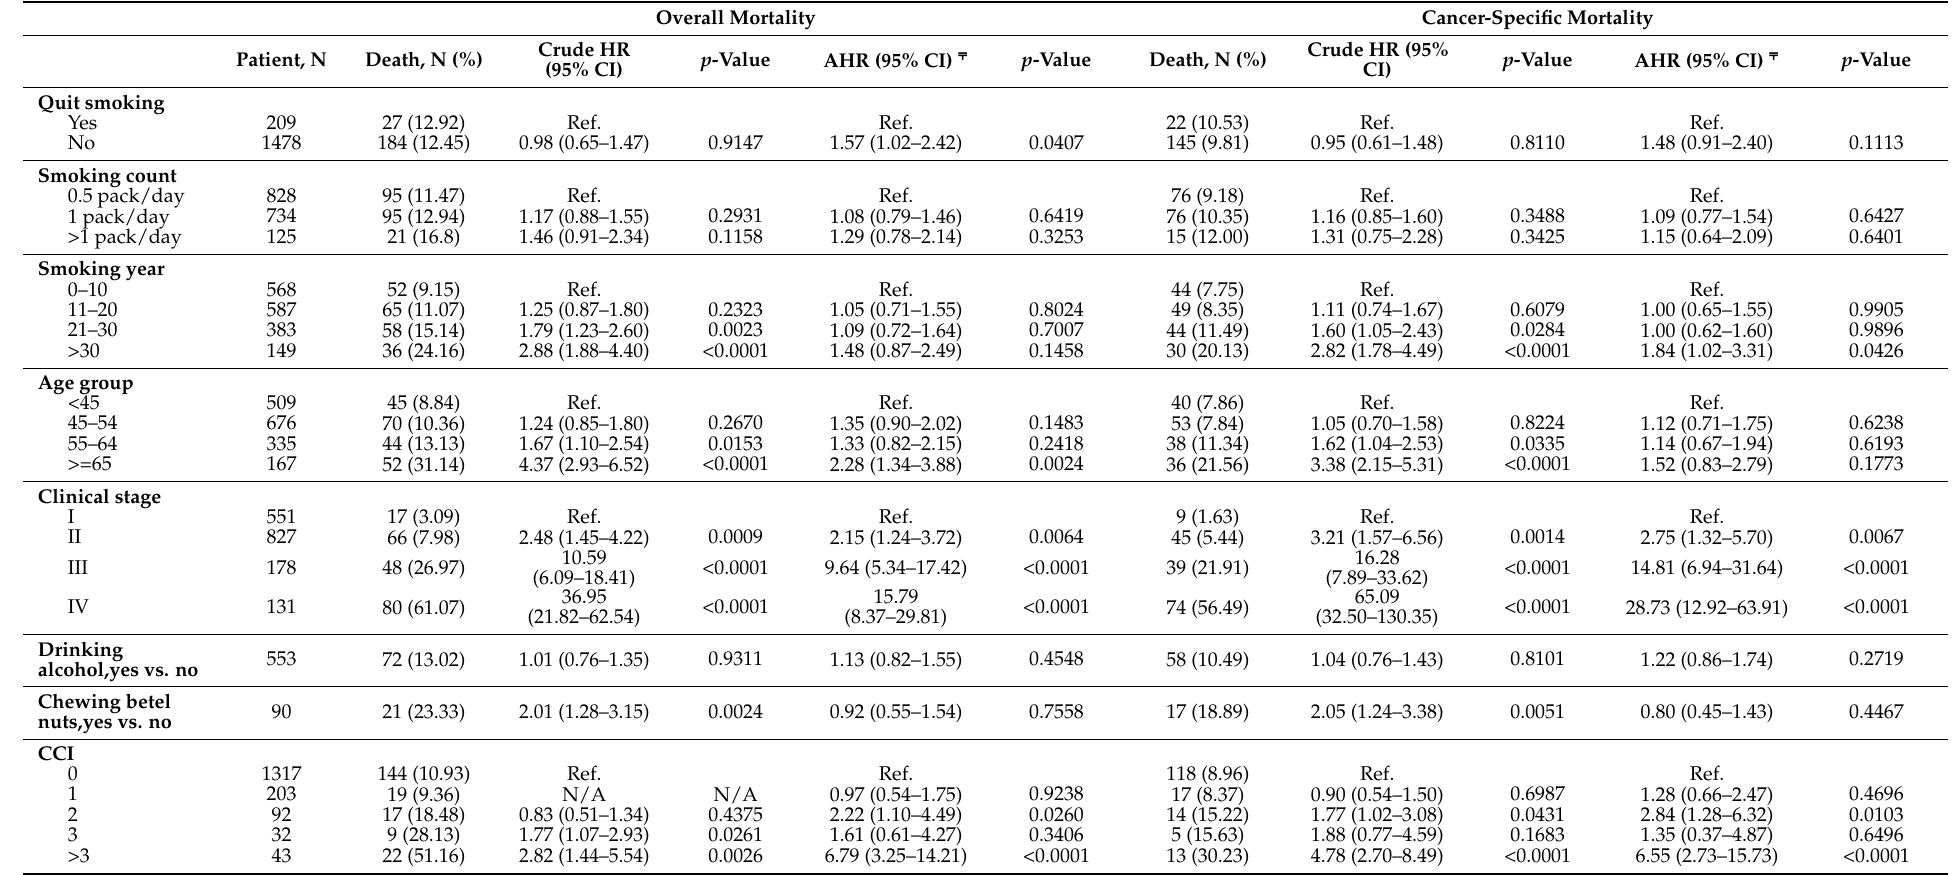
Table 3. The risk of mortality between ever smokers and current smokers.